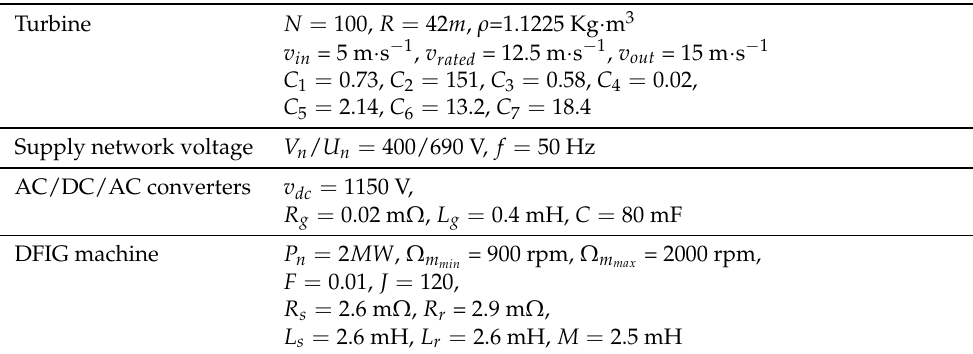
Table 2. DFIG-based wind energy conversion system